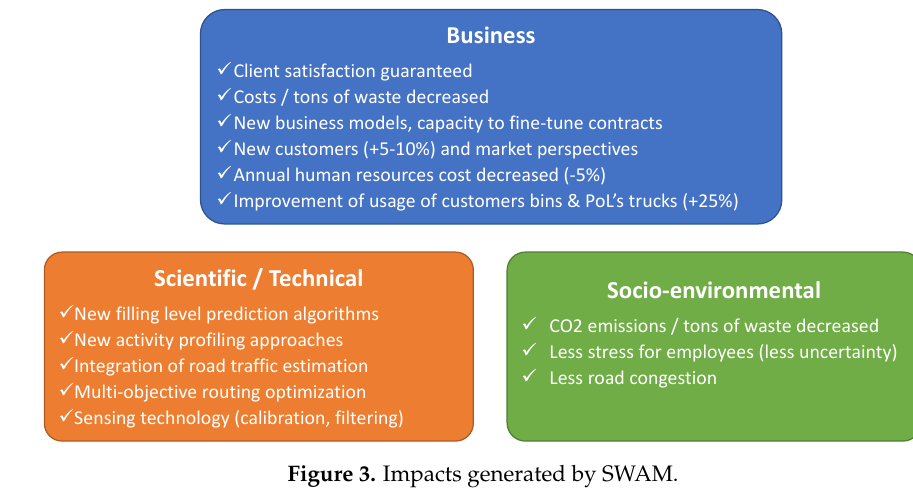
Figure 3. Impacts generated by SWAM.